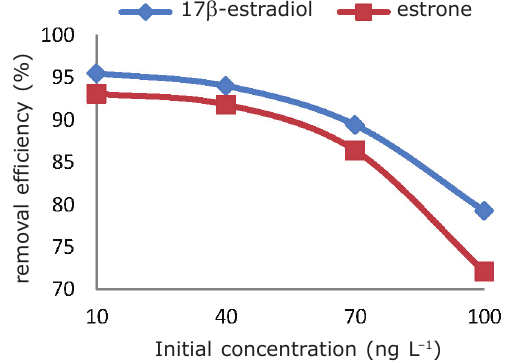
Fig. 7 – Effect of initial concentration of E2 and E1 hor- mones on removal efficiency (adsorbent dosage of 1.5 g L –1 , 60 min of contact time and pH of